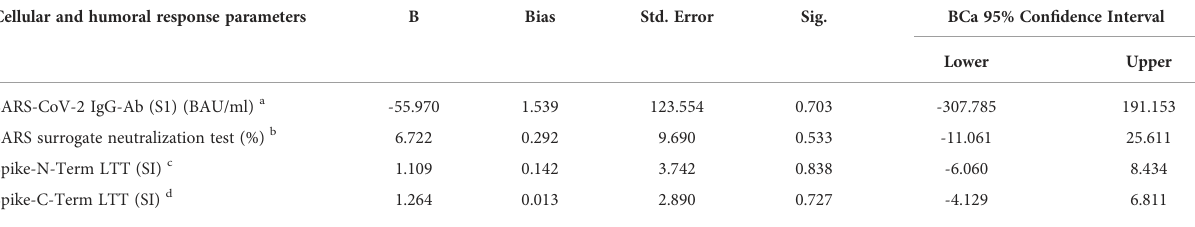
TABLE 6 Wild bootstrapping multivariate regression of hypertension with humoral and cellular response parameters as dependent variables in vaccinated health care workers. Cellular and humoral response